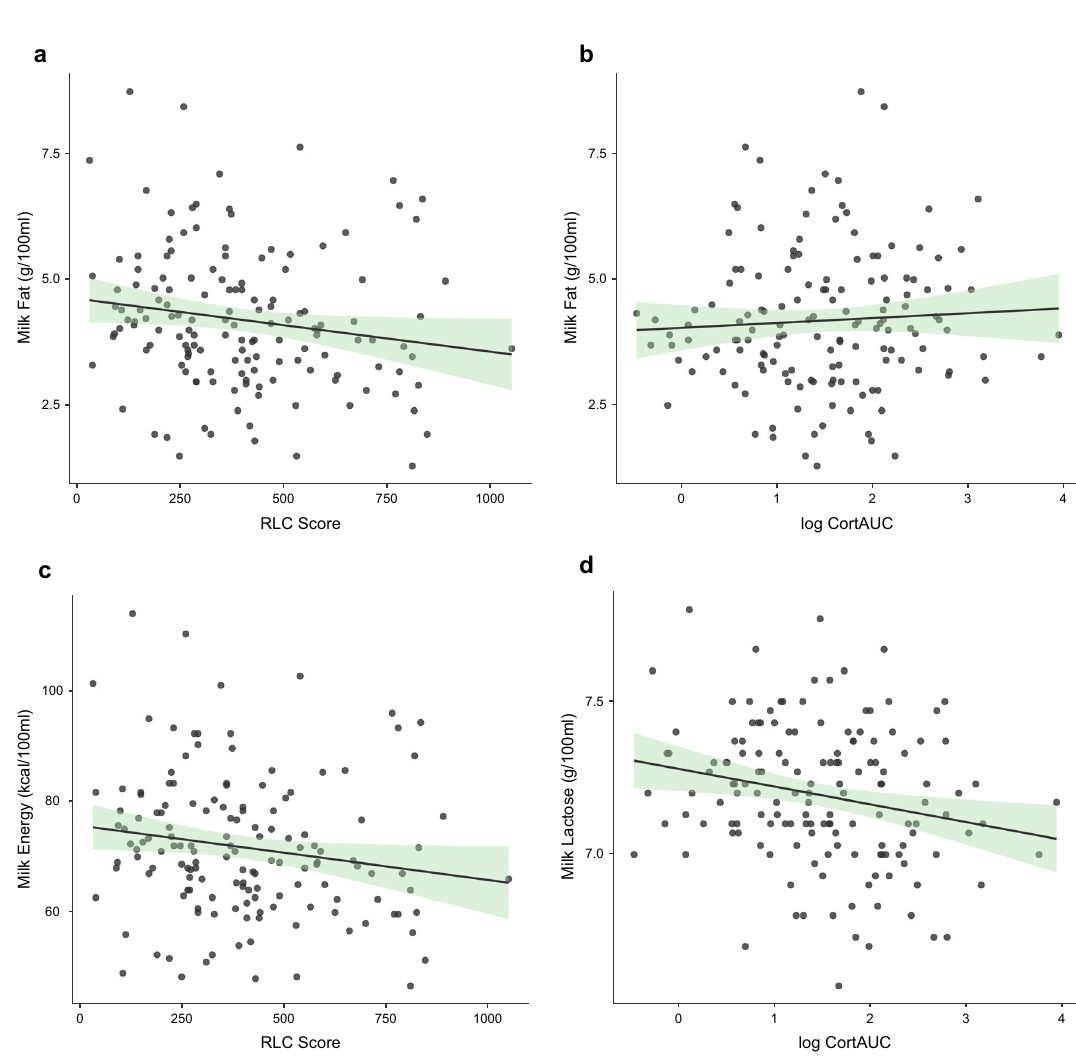
Figure 1. Recent Maternal stress (RLC) and cortisol levels are associated with the level of nutrients in breast milk. Higher maternal stress (RLC) is associated with lower levels of fat (panel a ) and energy (panel c ) in milk. Higher maternal cortisol is associated with higher fat (panel b ) and lower lactose (panel d ) in